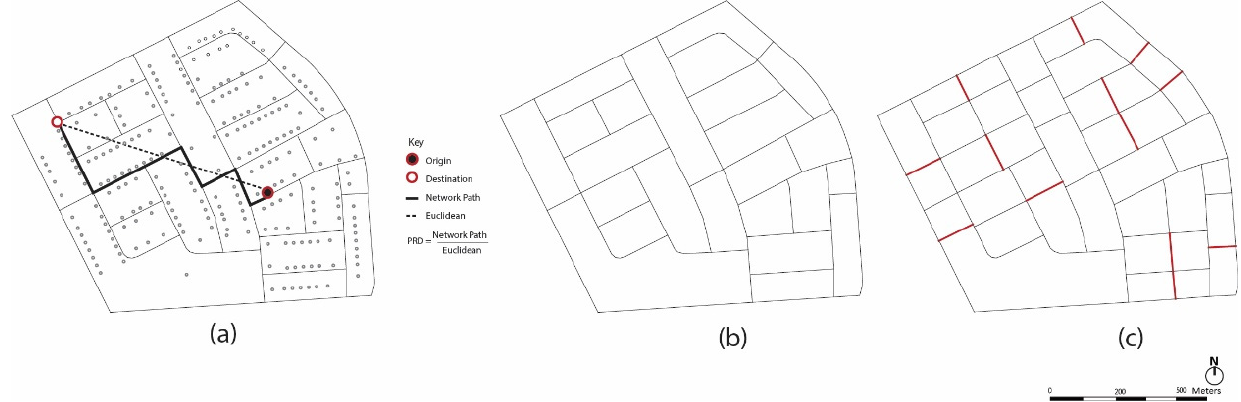
Figure 4. ( a ) An illustration of the route directness metric (PRD); ( b ) an illustration of the current network of the study (Network 1); ( c ) illustrates the current network with potential sikkak added (Network 2).